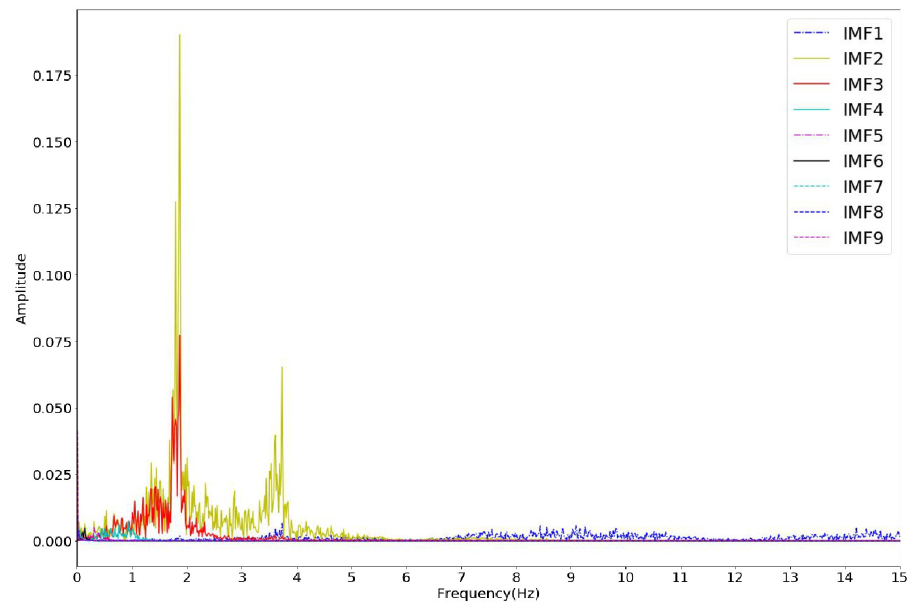
Fig 4. Frequency domain analysis of the decomposed IMF